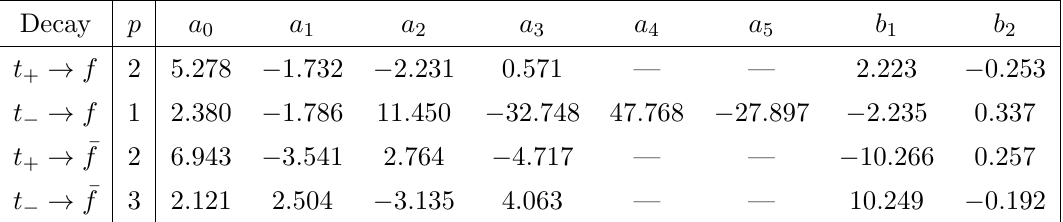
Table 2 . Parameters of the fitting function eq. (C.24) used to provide an adequate description of the W -decay products resulting from polarized top decays. The spectra themselves are depicted in figure 7.